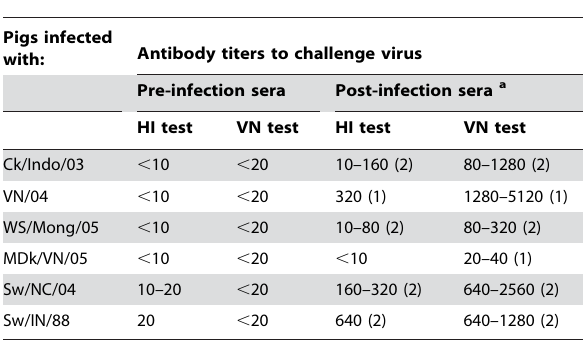
Table 2. Pig pre- and post-exposure serum antibody titers